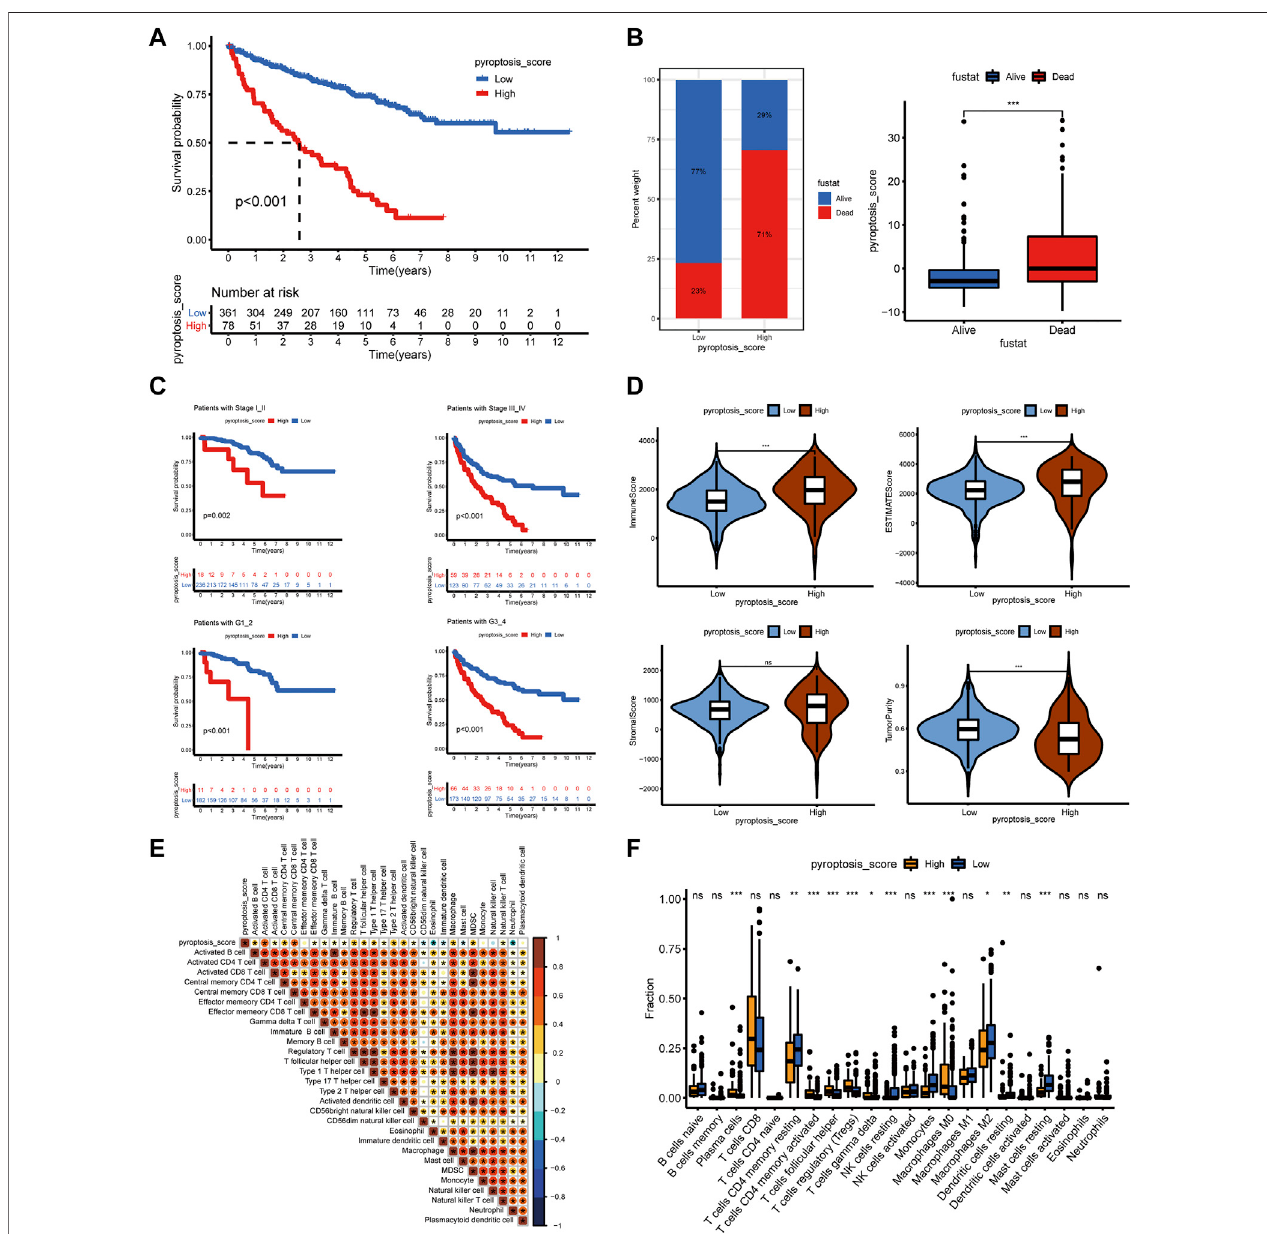
FIGURE4| Theclinicalcharacteristicsandimmunelandscapeofthepyroptosis-scoregroups. (A) Survivalcurvesofpatientswithhighandlowpyroptosis-scores. (B) The ratio of survival status in patients with high and low pyroptosis-scores and the difference in pyroptosis-score level of different survival status. (C) The survival curvesofpatientswithhighandlowpyroptosis-scoresatdifferentstagesandgrades. (D) Thedifferentlevelsofestimatescore,immunescore,stromalscore,andtumor purity in high and low pyroptosis-score groups. (E) Correlation analysis between pyroptosis-score and immune cells. (F) Differences in relative abundance of 22 immune cell types in patients with high and low pyroptosis-scores (*** p < 0.001, ** p < 0.01, * p <